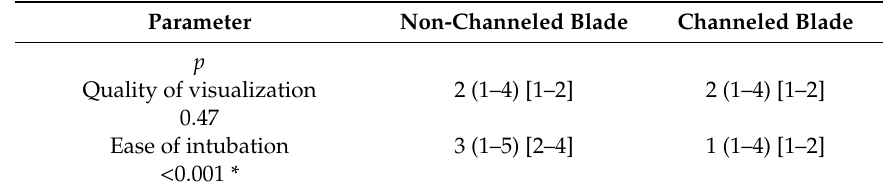
Table 3. Questionnaire assessing the feedback of